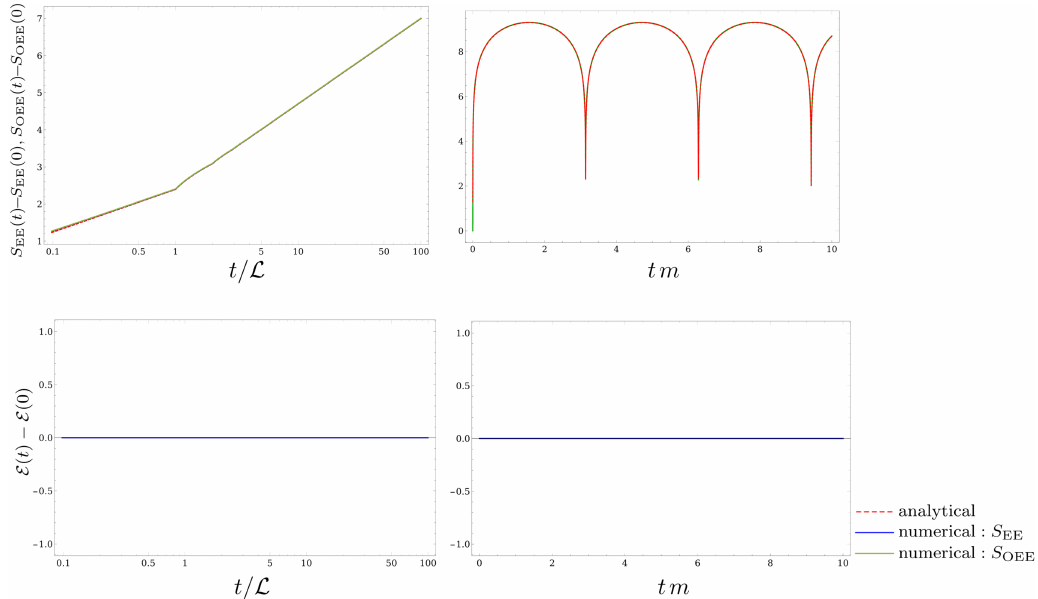
Figure 10 . These plots correspond to the case of a subsystem consisting of a single site on each side for m = 10 − 3 / L , β = 10 − 2 L and the total sites N = 1501 . We compare the analytical and numerical results for S , S and E . In the top-right panel, the periodic behavior with respect EE OEE to the parameter tm is